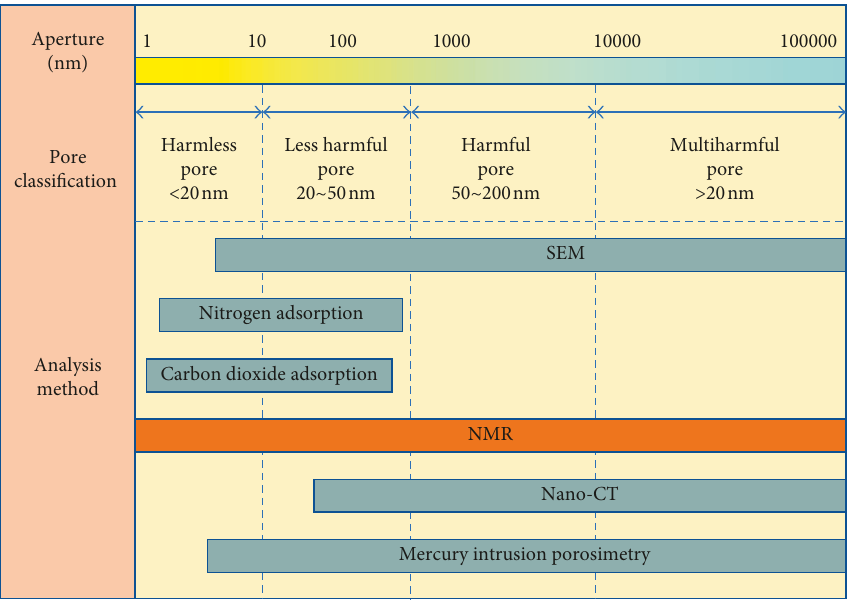
Figure 3: Aperture ranges (nm) for filling slurry pore properties’ characterization